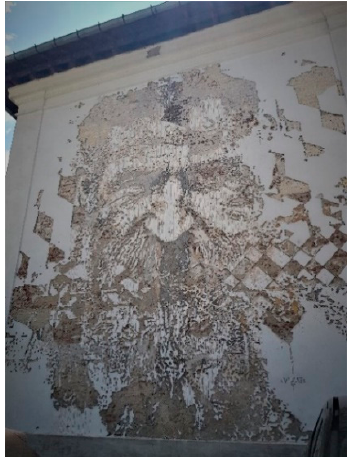
Figure 36. Brâncu ș i, UNArte, Bucharest by Vhils, 2016 (photo taken in 2022).